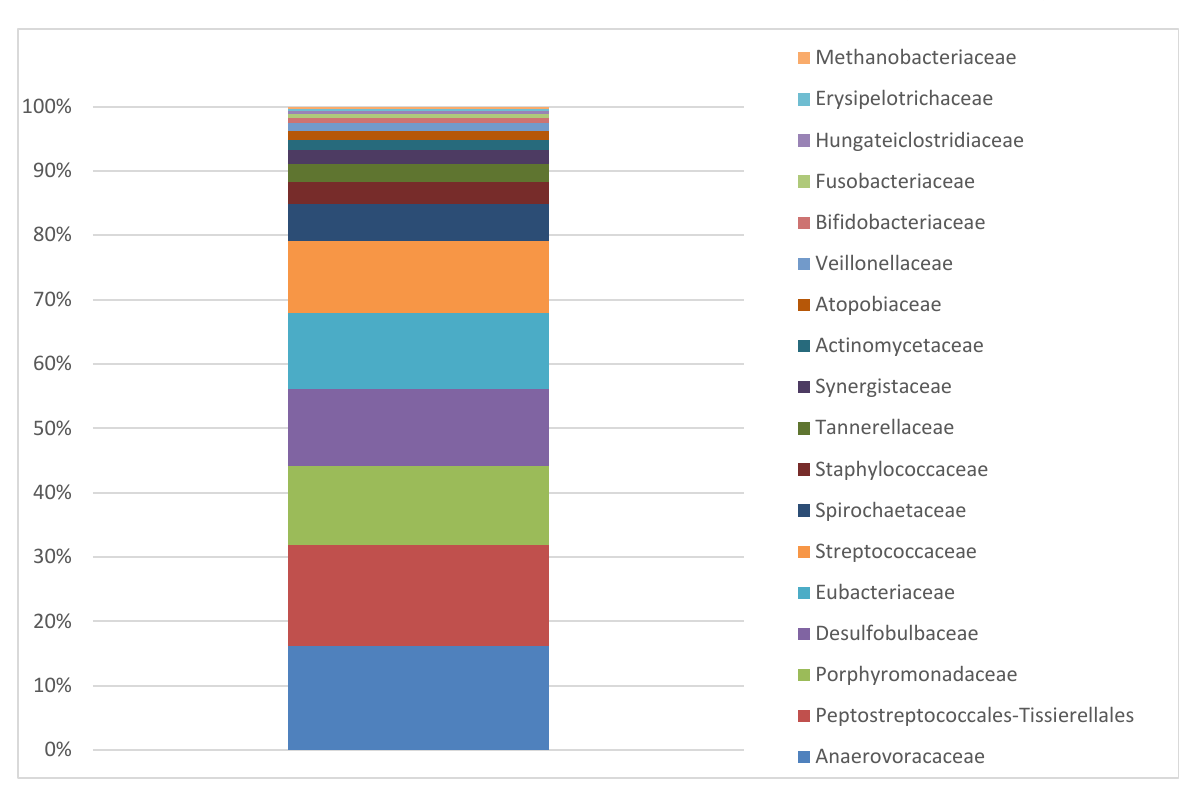
Figure 2. Rarefaction curve of microorganisms for the collective sample obtained from the 8- and 25-year-old implants.